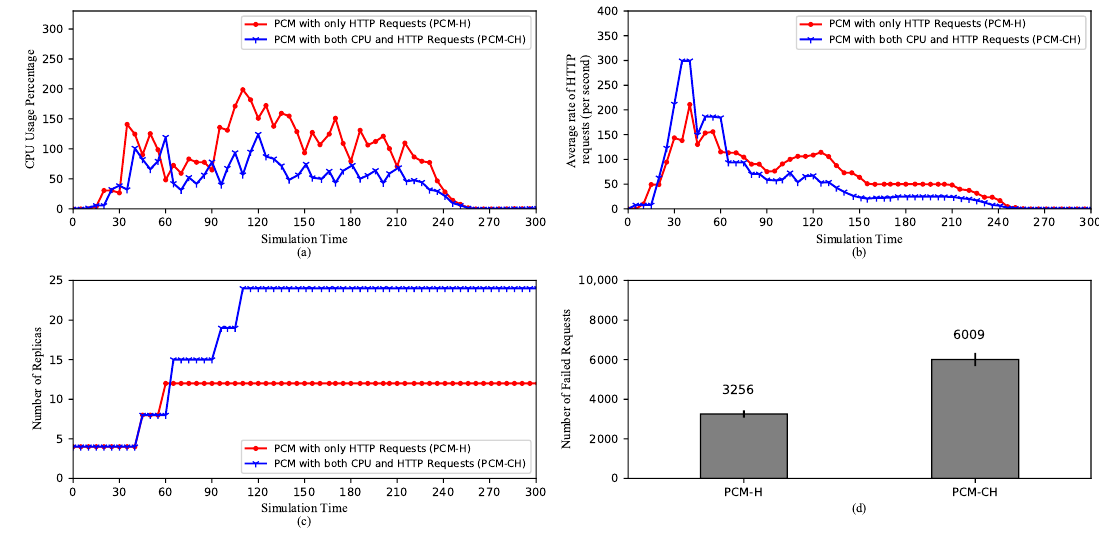
Figure 8. Comparison of HPA Performances with different custom metrics. ( a ) The average CPU usage. ( b ) The average rate of HTTP requests. ( c ) The scaling of the replica set. ( d ) The total number of the failed requests.